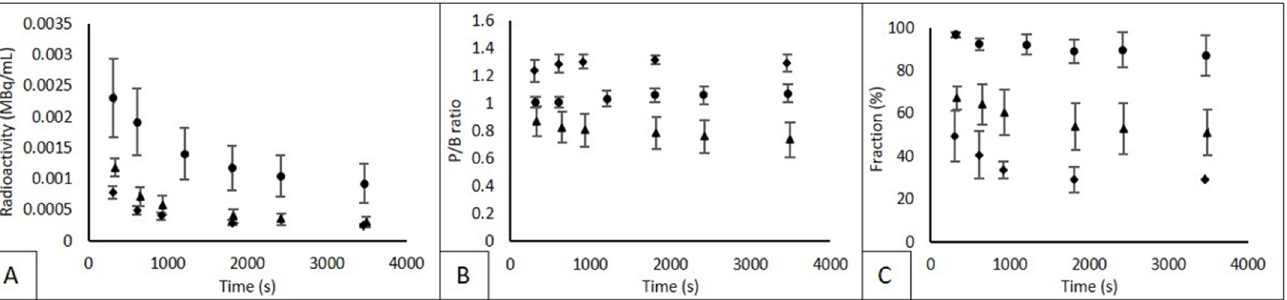
Figure 2. Whole blood radioactivity, P/B ratio and parent fraction. Abbreviations: Circles represent 11 C ‐ erlotinib, triangles represent 18 F ‐ afatinib and diamonds represent 11 C ‐ osimertinib in each graph. ( A ) whole ‐ blood radioactivity, ( B ) plasma ‐ to ‐ whole ‐ blood ratio (P/B). ( C ) the parent fraction. Mean and SD is given. In ( C ), the final measurement of 11c ‐ osimertinib only 1 measurement could be used.